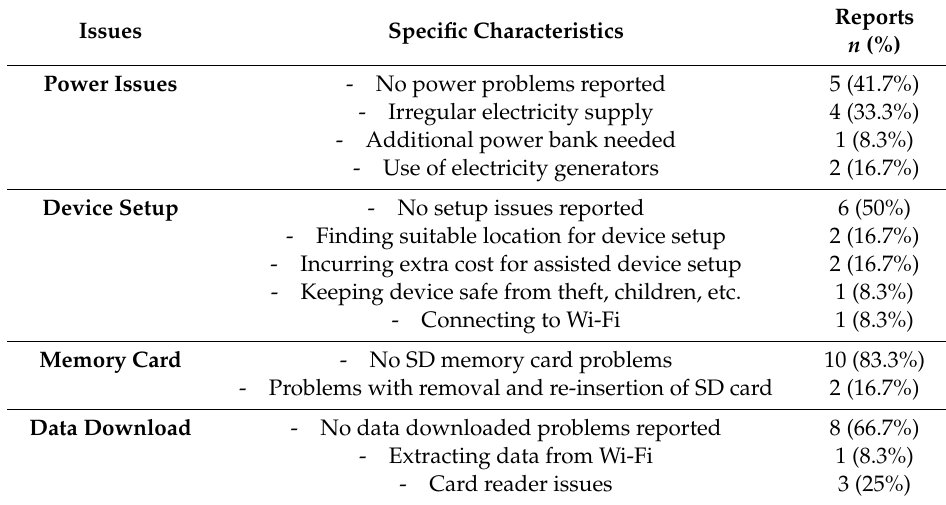
Table 3. Practical Challenges Identified during Field Use of PurpleAir-II-SD AQM Sensor ( N = 12).